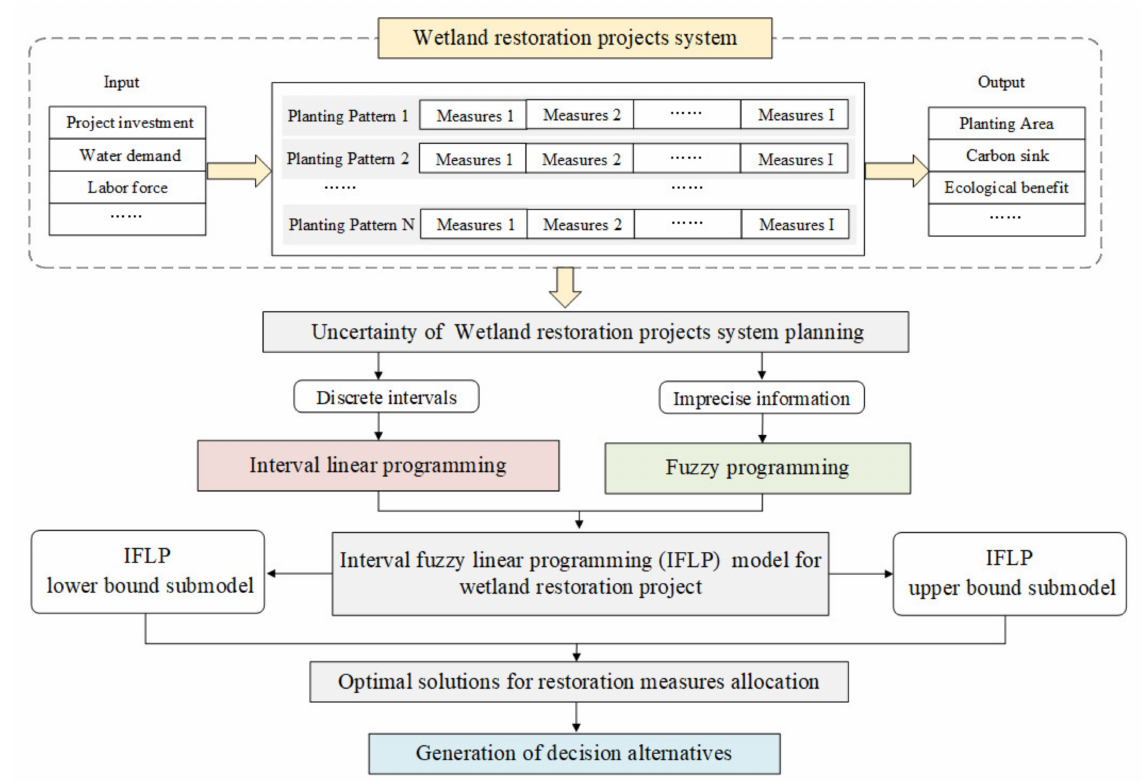
Figure 1. Framework of the developed IFLP model for a wetland restoration